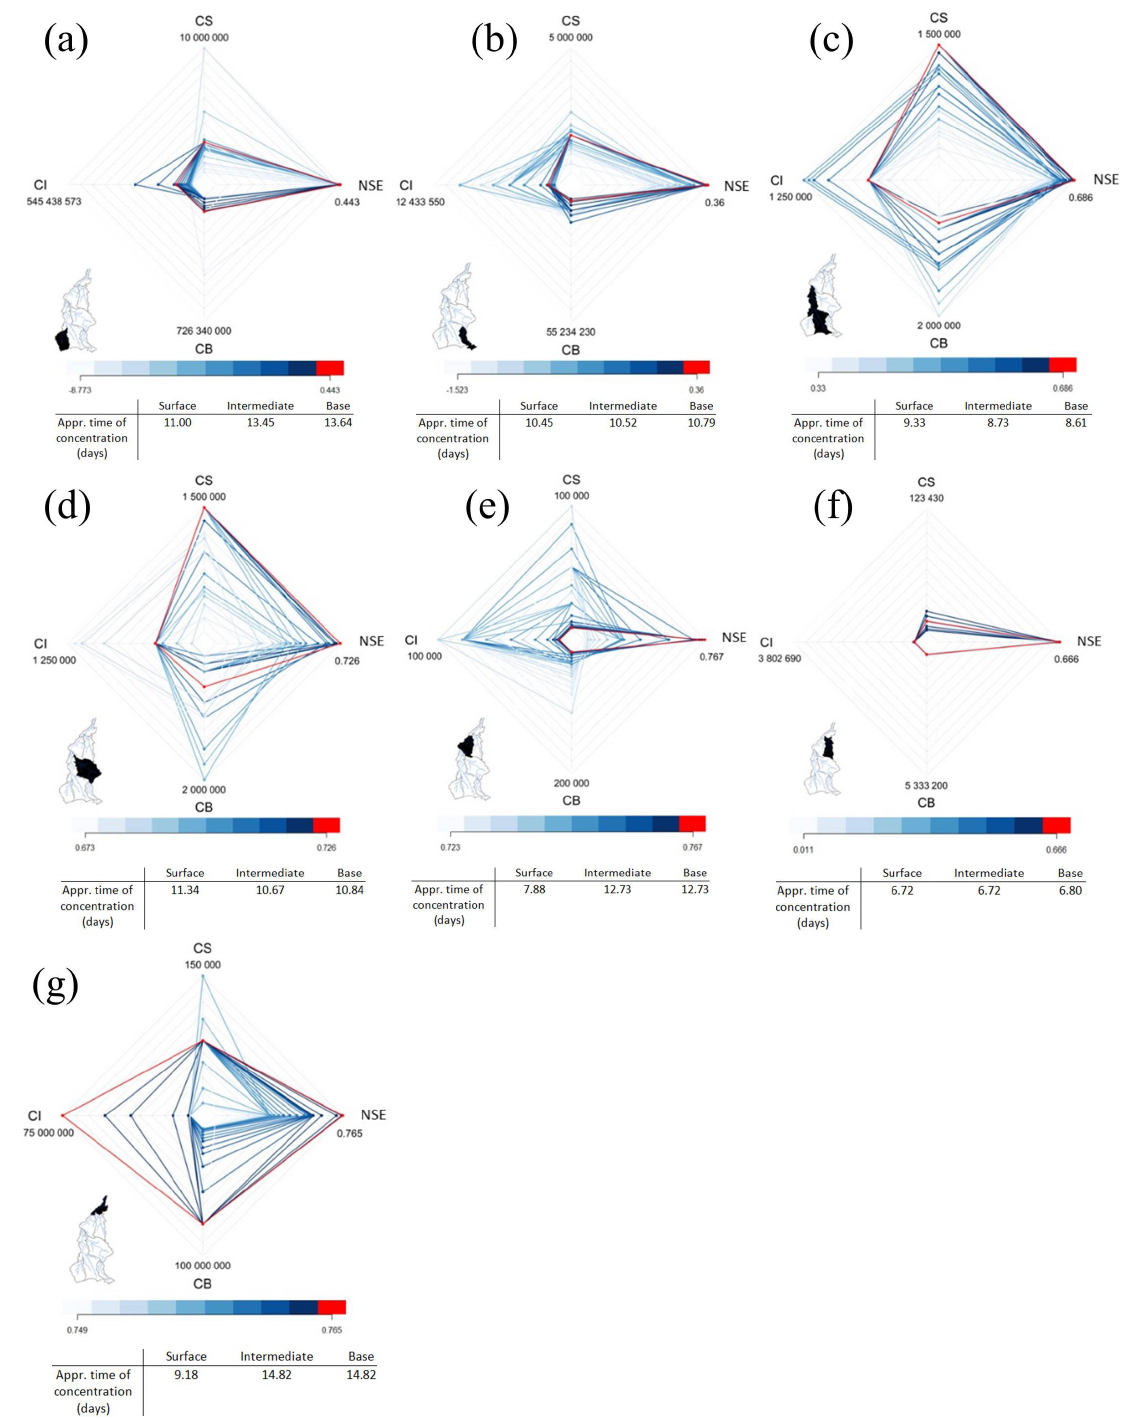
Figure 7. Calibration of the residence times ( τ) of the flow within the ED2 + R reservoirs of different grid cells in the domain through the adjustment of the non-dimensional C parameters. Overland, intermediate, and subsurface water flows are calibrated, respectively, through the adjustment parameters CS, CI, and CB (Fig. 2). The color bars refer to the model performance (NSE) of the specific parameter combination in the specific sub-basin. In red are the chosen combinations. At the bottom of each graph, there is a table providing the corresponding approx- imate average time of concentration (in days) for the cells in the sub-basin. (a) Upper Juruena (UJ); (b) Upper Teles Pires (UTP); (c) Lower Juruena (LJ); (d) Lower Teles Pires (LTP); (e) Upper Tapajós (UT); (f) Jamanxim (JA); and (g) Lower Tapajós (LT).